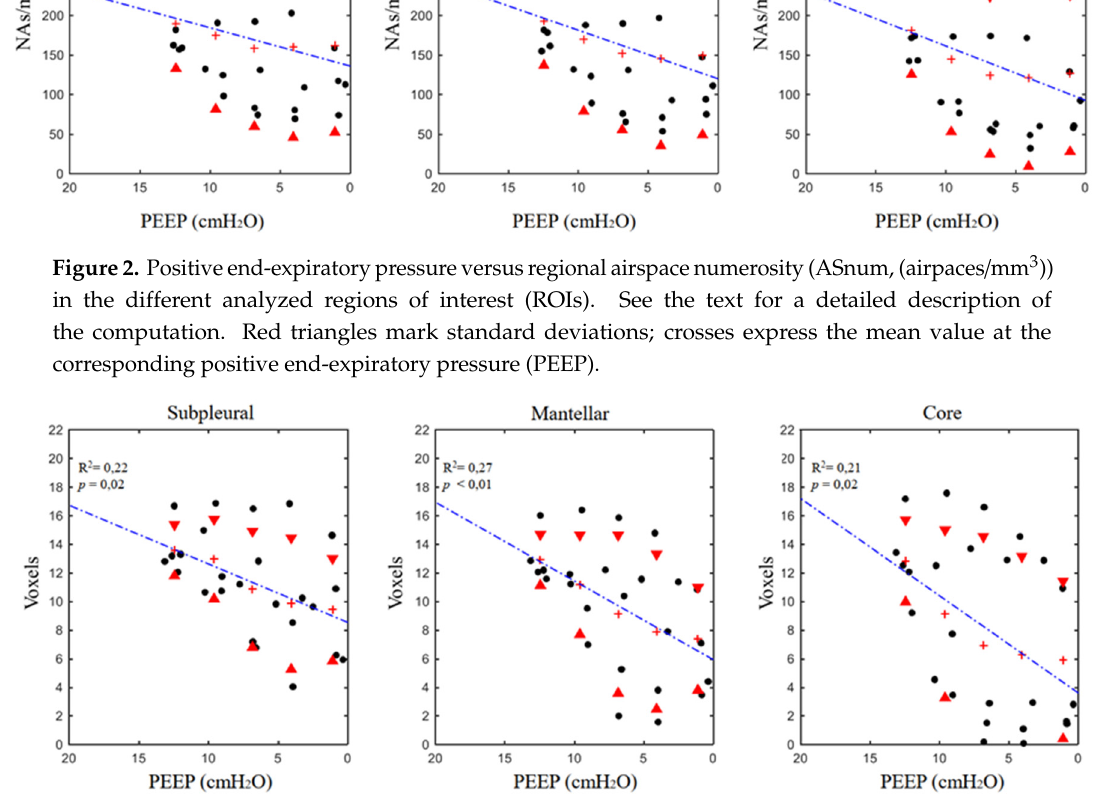
Figure 3. Positive end-expiratory pressure versus regional airspace dimensions expressed in voxels (1 voxel = 47.7 µm 3 ) in the different analyzed ROIs. See the text for a detailed description of the computation. Red triangles mark standard deviations; crosses express the mean value at the corresponding PEEP.